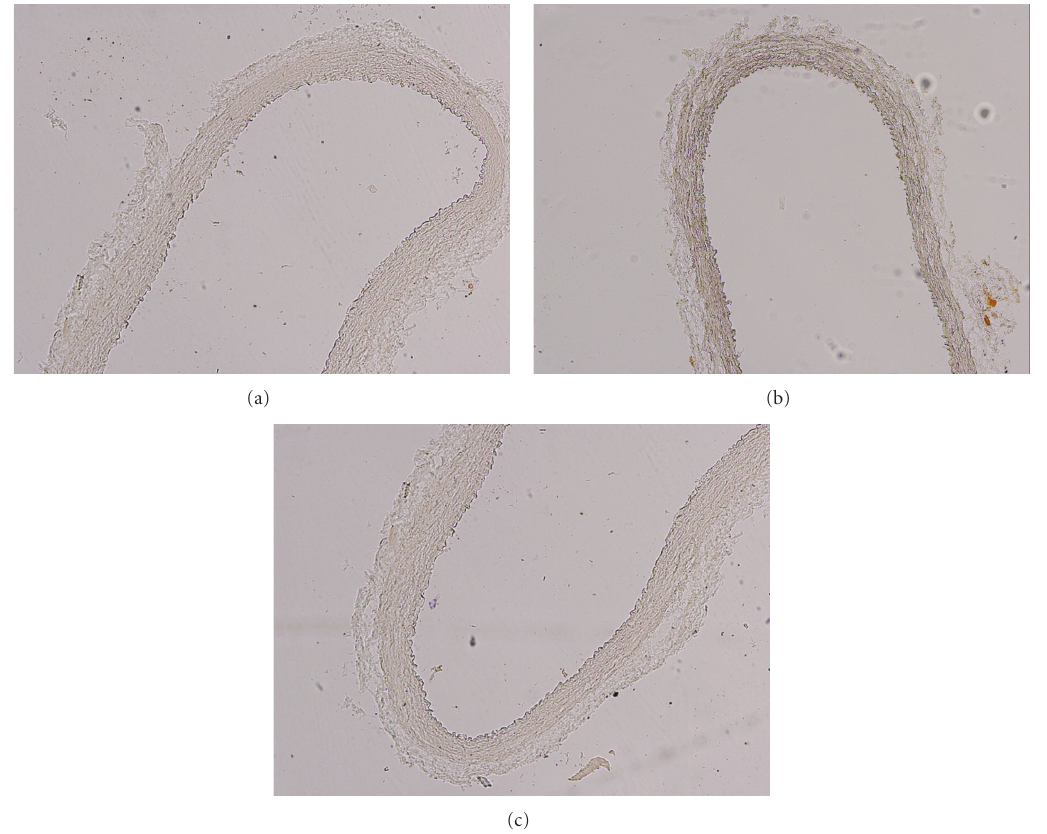
Figure 1: Photomicrographs of the proximal common carotid artery of the right side staining with Red-Oil. Original magnification × 100. Carotid artery from (a) control group; (b) cholesterol group; (c) cholesterol + fluvastatin group.